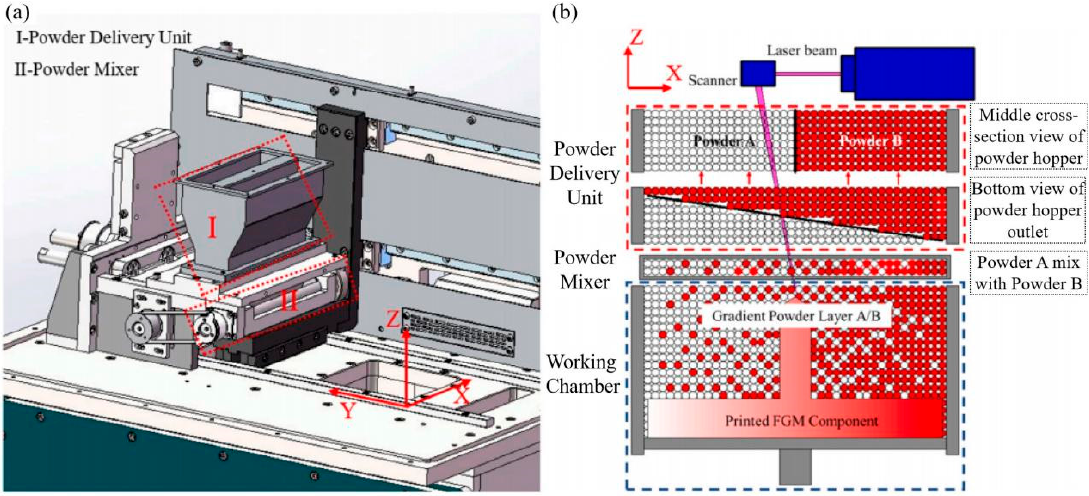
Figure 16. ( a ) Schematic of the self-developed compositionally-graded alloys LPBF system; ( b ) 2D section view of powder-delivery unit and mixer [175].